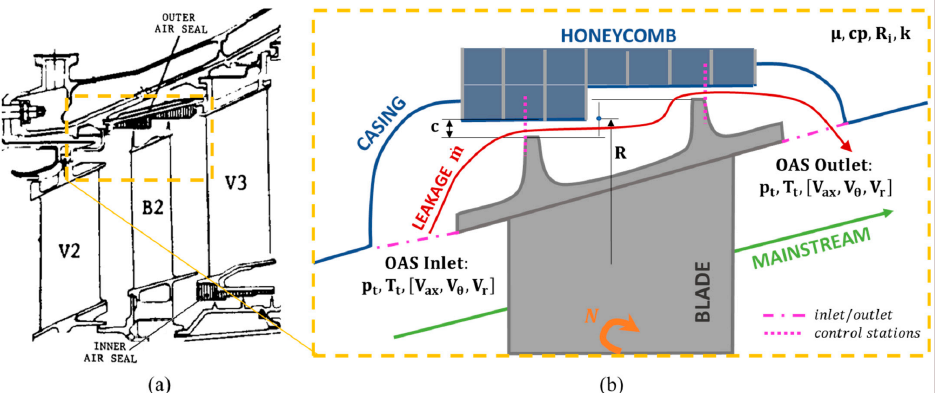
Figure 1. ( a ) A typical OAS of LPT [16]. ( b ) Meaningful quantities considered for flow through the